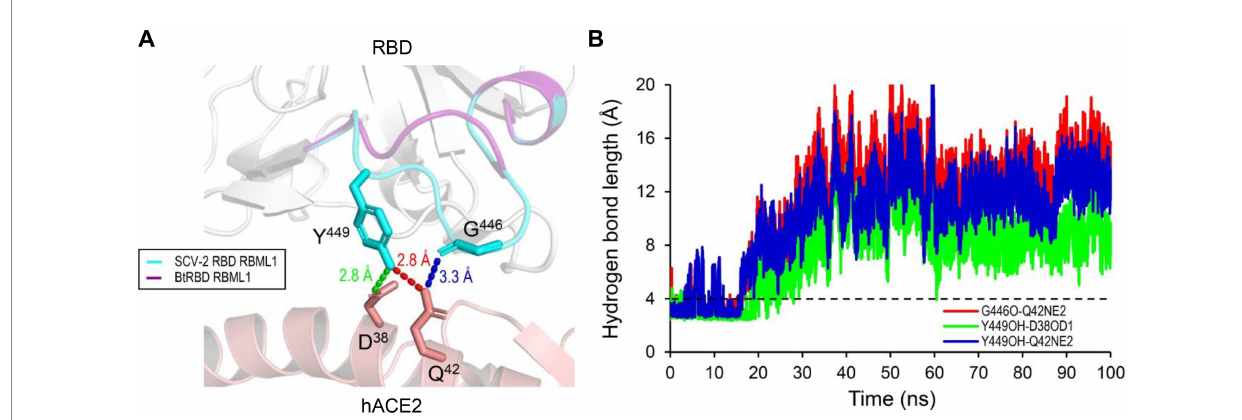
FIGURE 8 The structural basis of the RBML1 of SARS-CoV-2 RBD interacting with hACE2. (A) Gly-446 and Tyr-449 of the RBML1 (colored in cyan) interact with Gln-42 and Asp-38 of hACE2 via three hydrogen bonds (pdb entry 6LZG). In the model of BtRBD, its RBML1 far away from the interface is colored in purple. (B) The lifetimes of the hydrogen bonds during 100-ns MD simulations. The dashed line represents the length threshold (4 Å) of a hydrogen